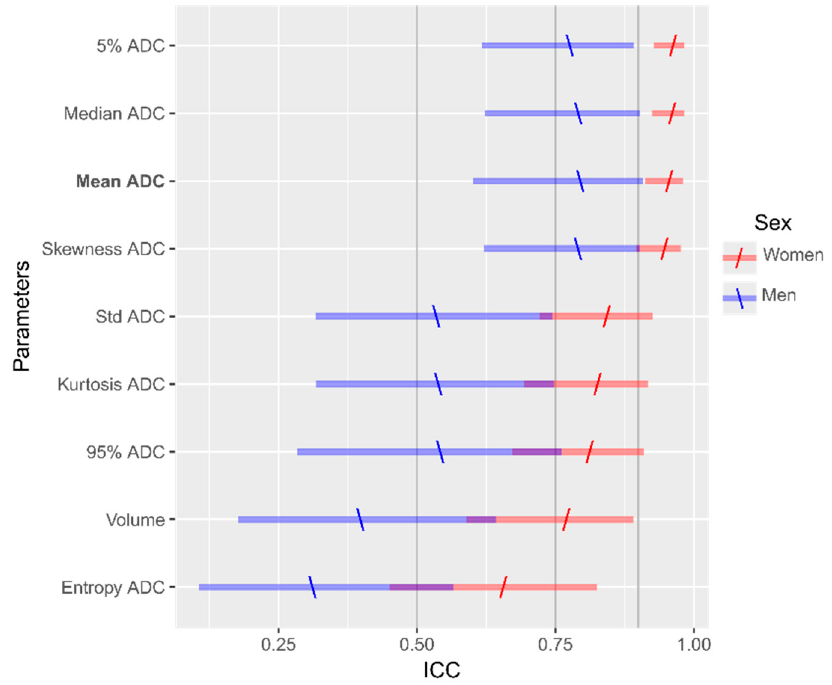
Figure 5. Graphical representation of the inter-observer Intraclass Correlation Coefficients (ICC) with lower and upper limits of the 95% confidence intervals calculated for parameters derived from the apparent diffusion coefficient histogram. The population is divided by sex (blue: men with prostate cancer, red: women with breast cancer), back-slashes and forward slashes represent the estimated ICC values for men and women, respectively. For our cohort, the intervals were narrower and ICC values nearer to 1 in women, indicating greater reproducibility than in men.